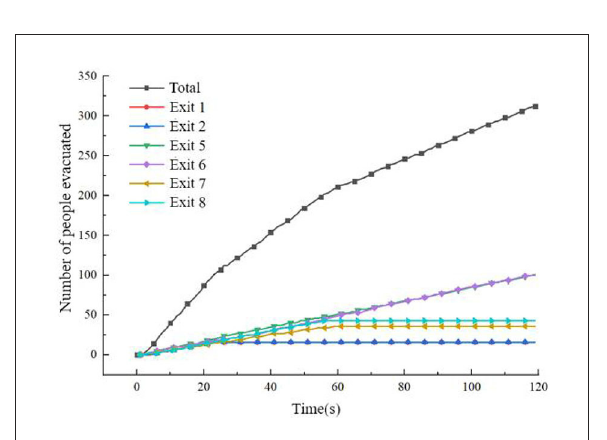
FIGURE14 Statistics of the number of evacuees when the cabin is horizontal.